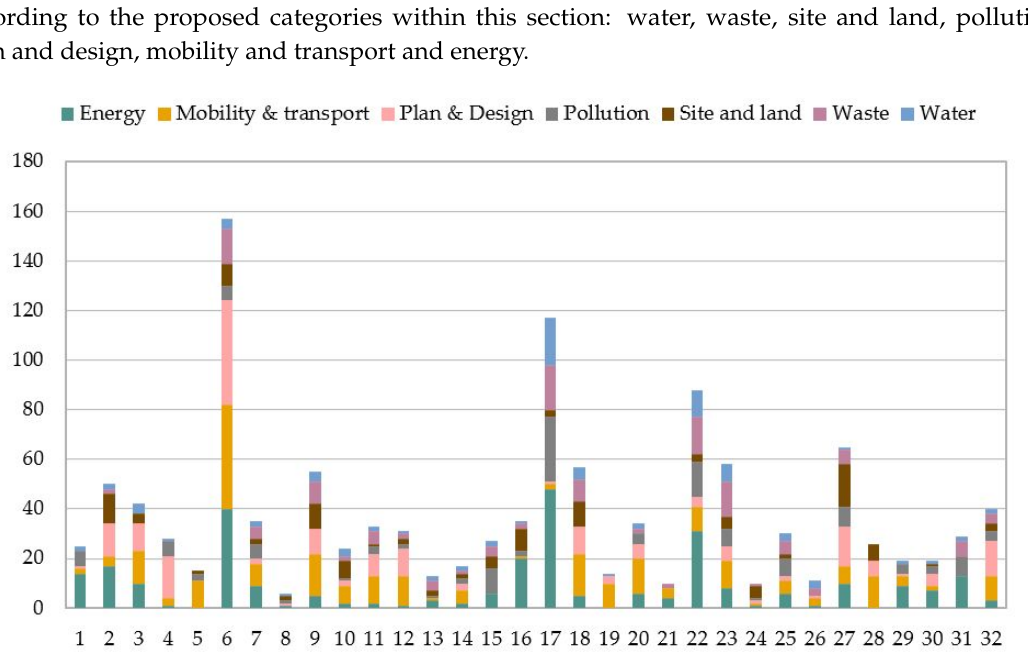
Figure 3. Distribution of environmental aspects considered by framework.